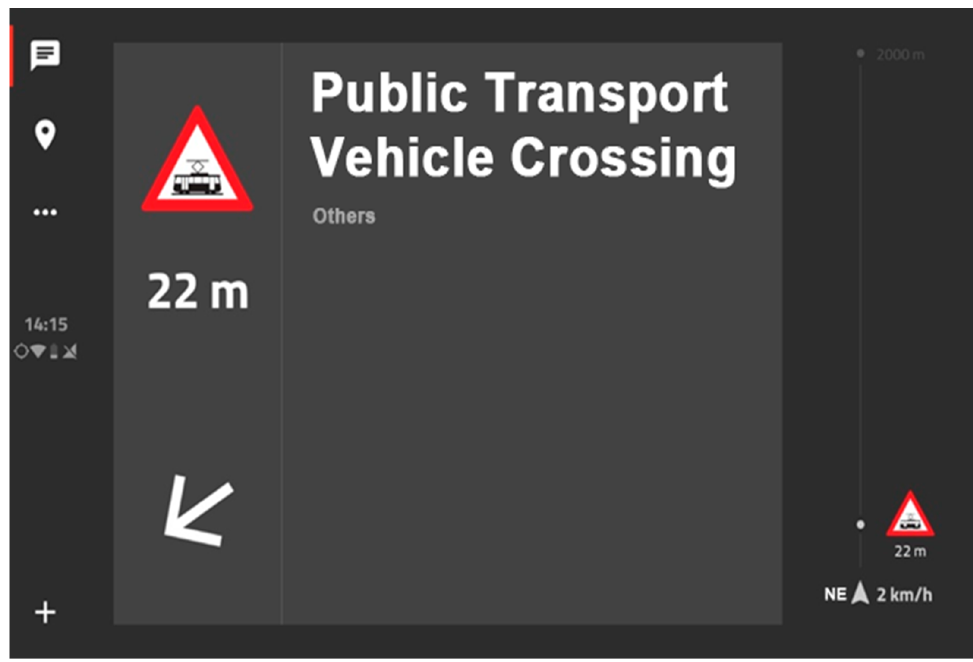
Figure 10. HMI of Public transport vehicle crossing use-case.